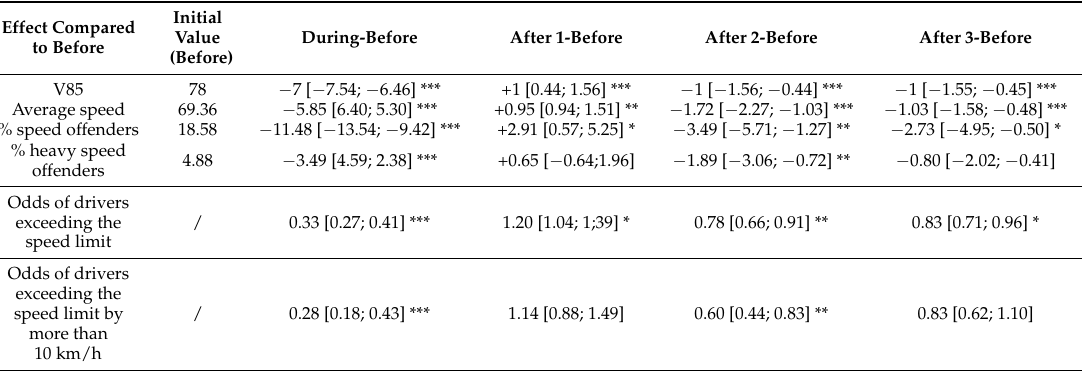
Table 3. Results of the overall effects in regional police unit 1.